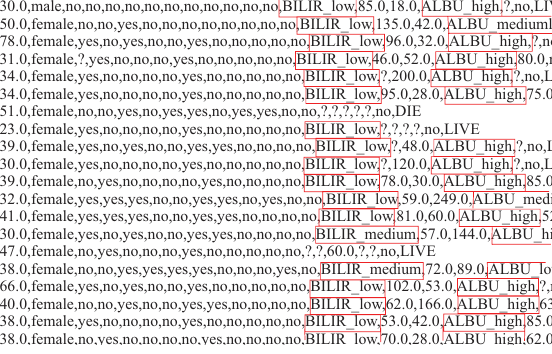
Fig. 15. A part of the transformed “hepatitis.arff”